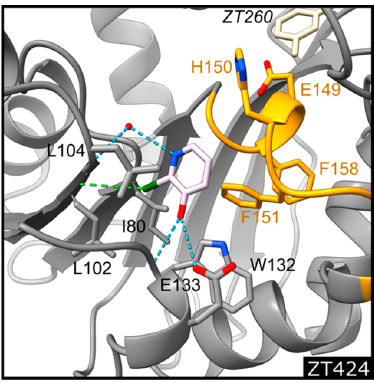
Figure 6. Detailed representation of binding of ZT424 (light pink) at the cofactor binding site. The protein is represented as a ribbon, the side chains of residues involved in ligand biding are shown as sticks and labelled, water molecules as red spheres, and hydrogen and halogen bonds as blue and green dotted lines, respectively. Residues 148–151 forming helix η 1 are coloured orange. The position of ZT260, coloured beige, in the substrate binding site is also indicated for easier comparison with Figures 4 and 5.